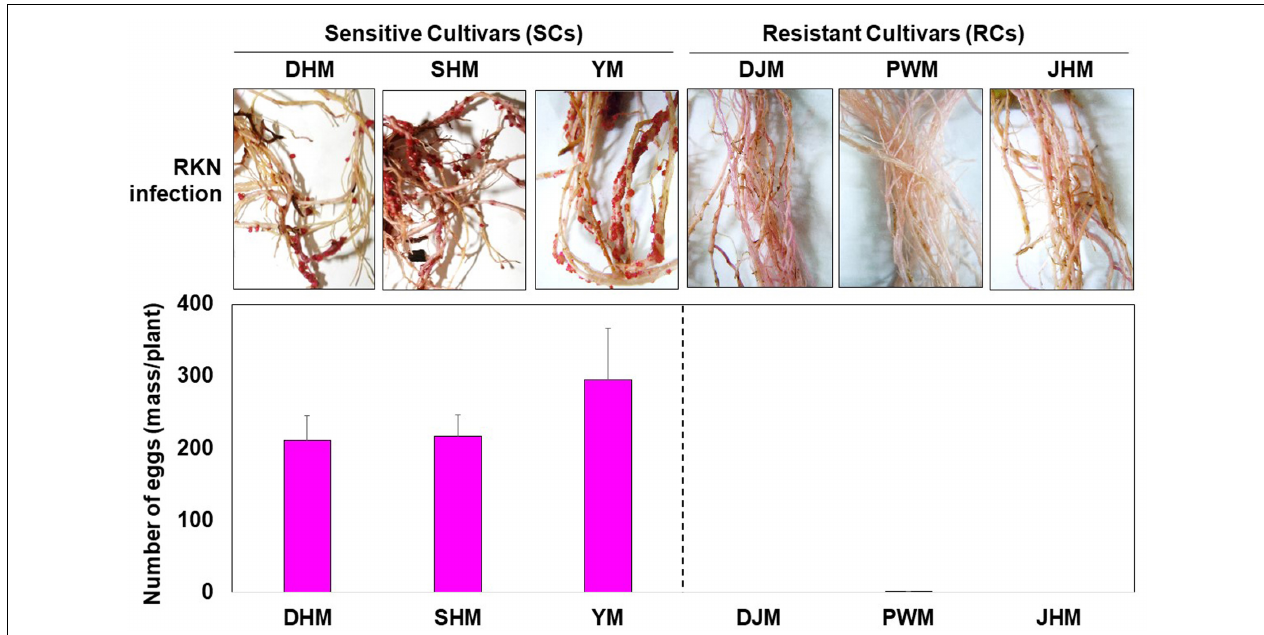
FIGURE 1 | Effect of the root-knot nematode (RKN) Meloidogyne incognita on susceptible cultivars (SCs; DHM, SHM, and YM) and resistant cultivars (RCs; DJM, PWM, and JHM) of sweetpotato. Plants were grown under greenhouse conditions for 1 month. Egg masses were formed in non-sterilized sand containing M. incognita but not in sweetpotato plants cultured in sterilized soil. Data represent mean ± standard deviation (SD) of 10 replicates. DHM, Dahomi; SHM, Shinhwangmi; YM, Yulmi; DJM, Danjami; PWM, Pungwonmi; JHM,